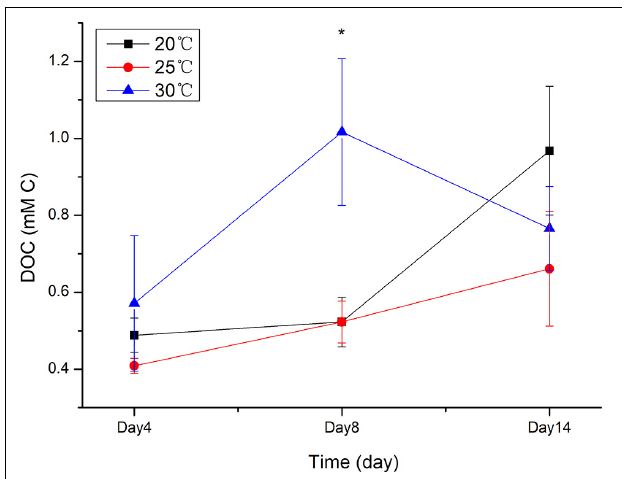
FIGURE 2 | DOC concentrations on days 4, 8, and 14 at different temperatures in the Skeletonema sp. culture. Values are the means ± SD, n = 6 (six replicate cultures). *Indicates significant difference between different treatments ( p < 0.05).